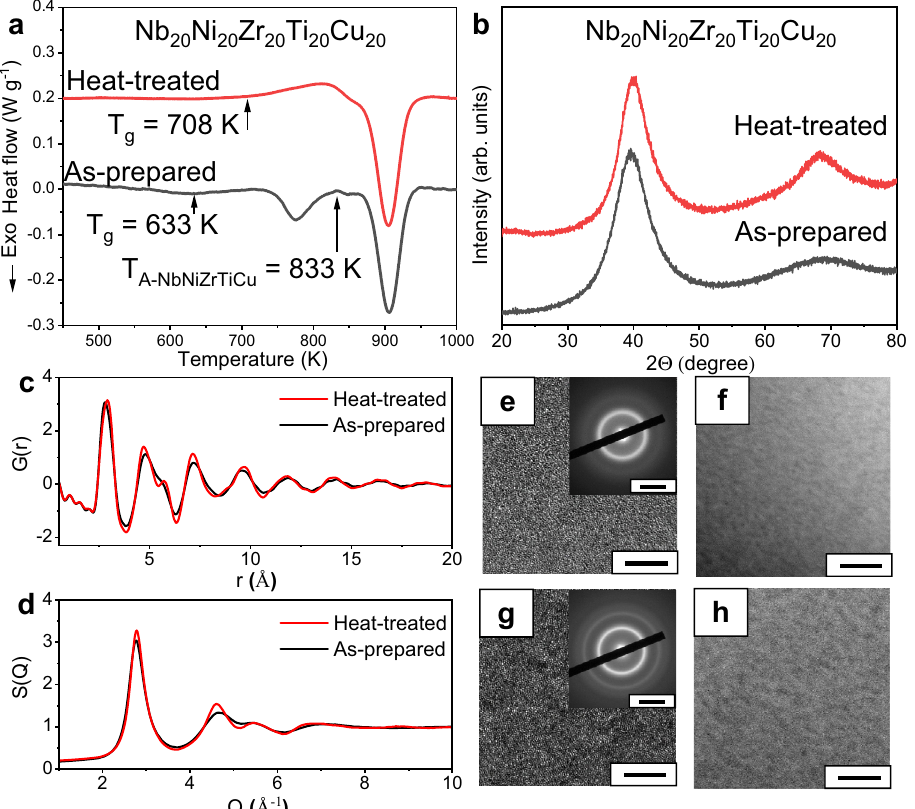
Fig. 7 DSC curve, X-ray diffraction, synchrotron X-ray diffraction, HRTEM, SAED, and HAADF analyses of the as-prepared and heat-treated NbNiZrTiCu HEMGs. a DSC curve of the as-prepared and heat-treated sample. The as-prepared sample shows a T g of 633 K. After heated to T = 833 K, the previous fi rst exothermic peak disappears and the heat-treated sample shows a T A-NbNiZrTiCu g of 708 K. To highlight the phase transitions, the curve of the crystallized HEMG (samples heated to 1173 K) was subtracted. b XRD results of the as-prepared and heat-treated samples. c Synchrotron X-ray diffraction results of the as-prepared and heat-treated samples in real space measured at room temperature. d Synchrotron X-ray diffraction results of the as-prepared and heat-treated samples in Q -space measured at room temperature. e HRTEM (scale bar: 5 nm) and SAED (inset, scale bar: 5 nm − 1 ) result of the as-prepared sample. f HAADF (scale bar: 20 nm) result of the as-prepared sample. g , h Same as e , f but for the heat-treated sample. The results show the heat-treated sample remains amorphous with different glass structures and no crystallization or detectable compositional inhomogeneity. Additional HRTEM results are in Supplementary Note